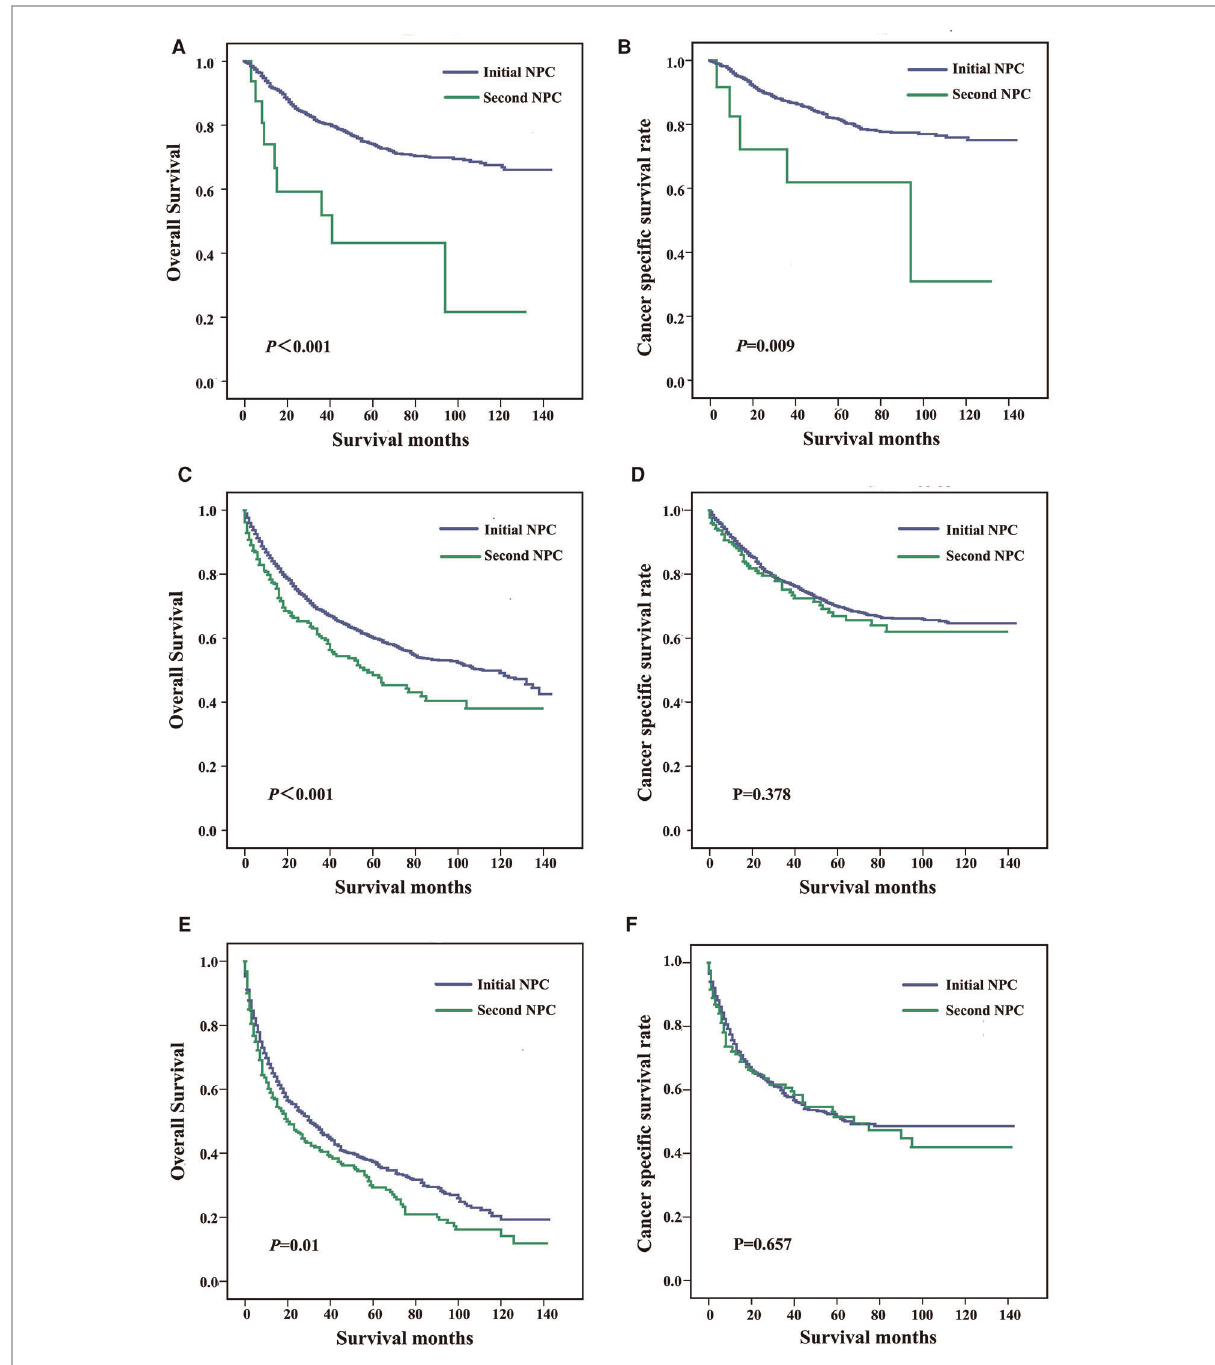
FIGURE 4 Survival curves for patients strati fi ed by age at diagnosis, including <45 years ( A,B ), 45-64 years ( C,D ), and ≥ 65 years ( E,F